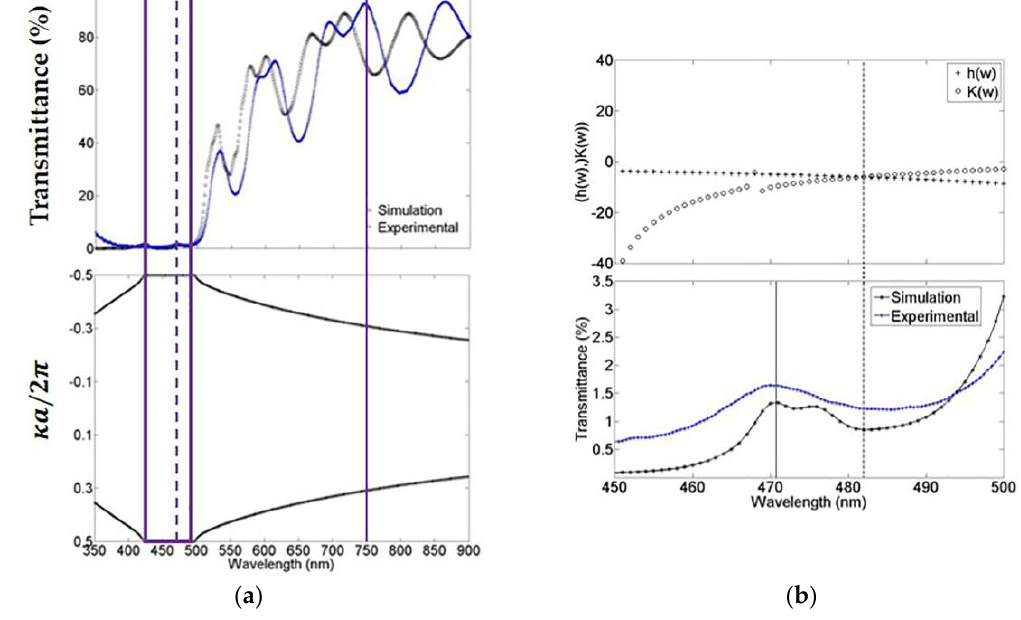
Figure 2. These figures show a comparison of the photonic band structure and localized mode calculation. ( a ) The theoretical and experimental transmission spectrum of a microcavity that was obtained in the visible-near-infrared range, its localized mode at 472 nm (broken line) and its bandgap (empty box); and ( b ) Comparison of both theoretical localized mode values and the experimental value that was measured with its spectrum of transmission. For the bandgap (a, bottom) and localized mode calculation (b, top), we used the mean of the complex refractive indexes norm within the whole wavelength range being explored.